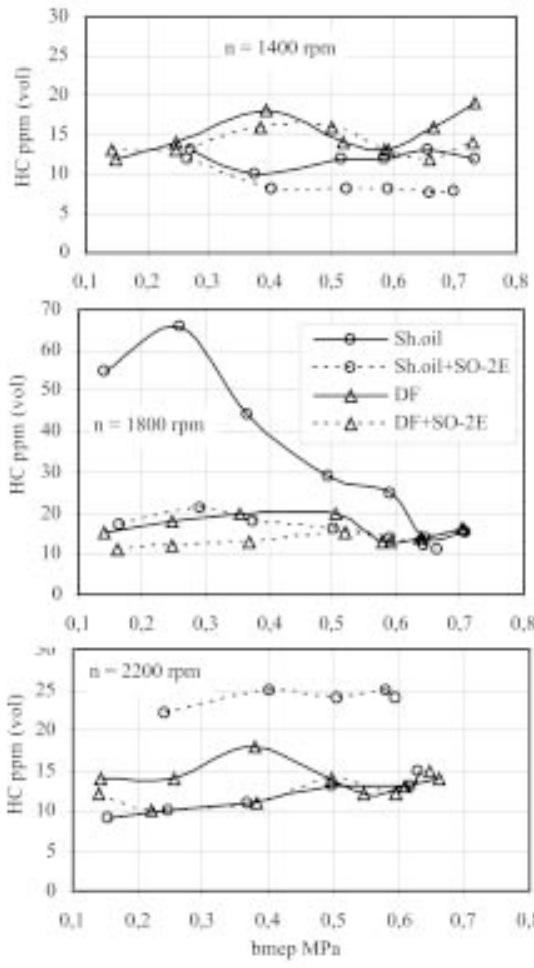
Fig 5 . Hydrocarbons HC emissions in Diesel exhausts as a function of engine load (bmep) at various revolution